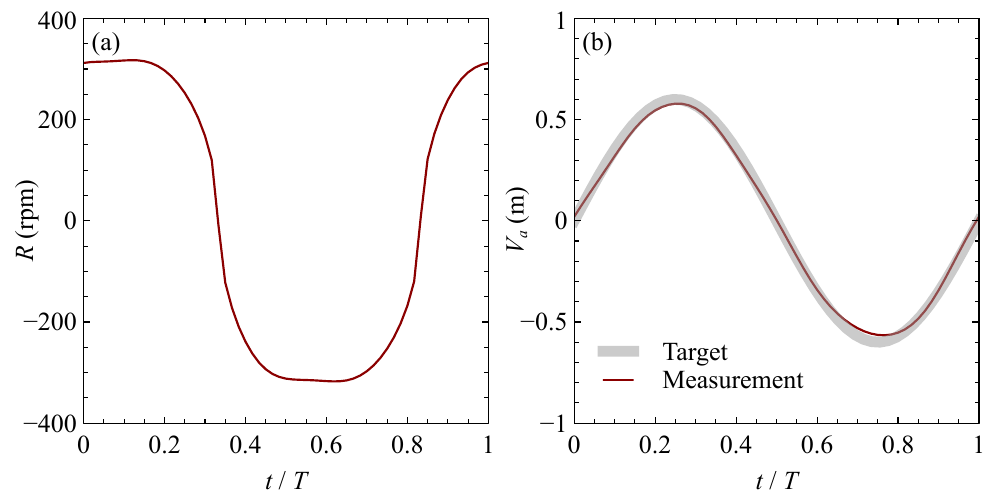
Figure 5. ( a ) Time series of rotational speed. ( b ) Time series of velocity using the U-tube